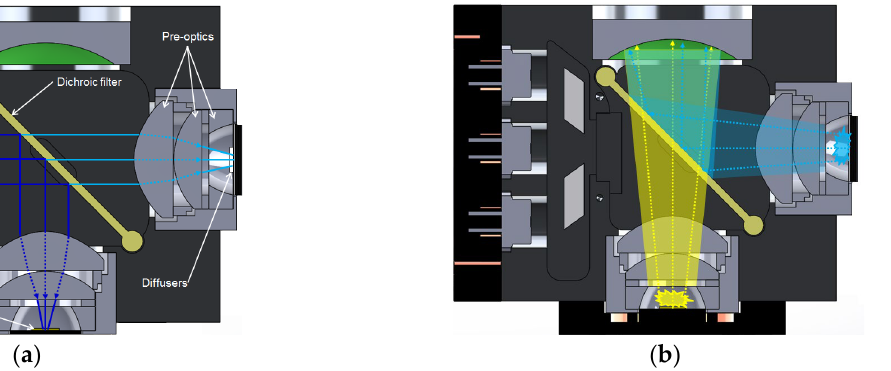
Figure 1. Basic optical structure of the white light source module. ( a ) Blue laser diode beam propagation path; ( b ) light propagation path of phosphor excitation and diffusion components.